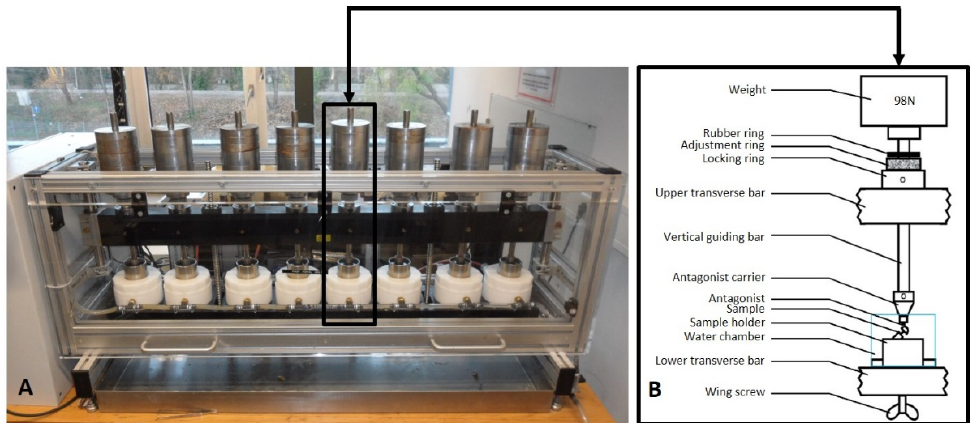
Figure 6. ( A ) The assemblies mounted in the artificial mastication machine CS-4.8 (SD Mechatronik, Table 1. Settings of the chewing simulator.